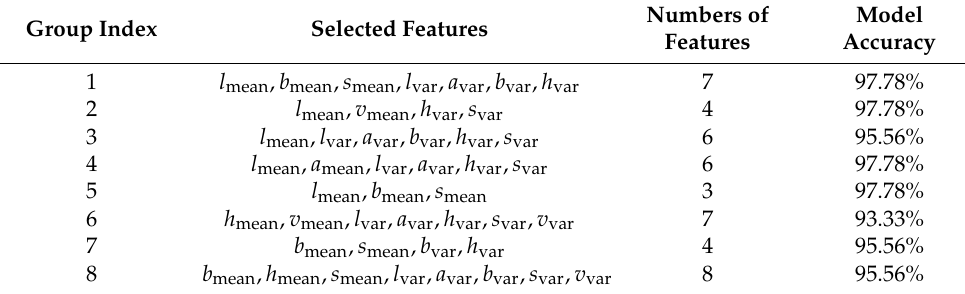
Table 3. Comparison results for different feature subsets searched by